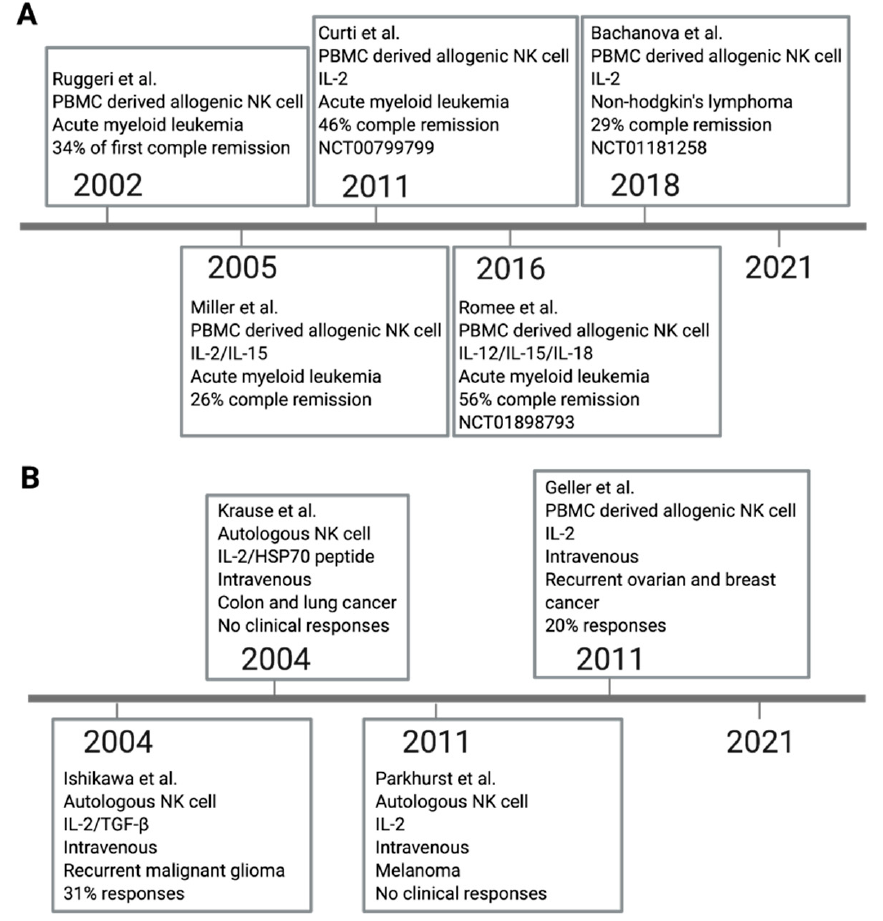
Figure 2. Clinical trials of NK-cell-based cancer therapy. A large number of NK cell clinical trials have been studied, and some remarkable studies in hematologic cancers ( A ) and solid tumors ( B ) were selected.